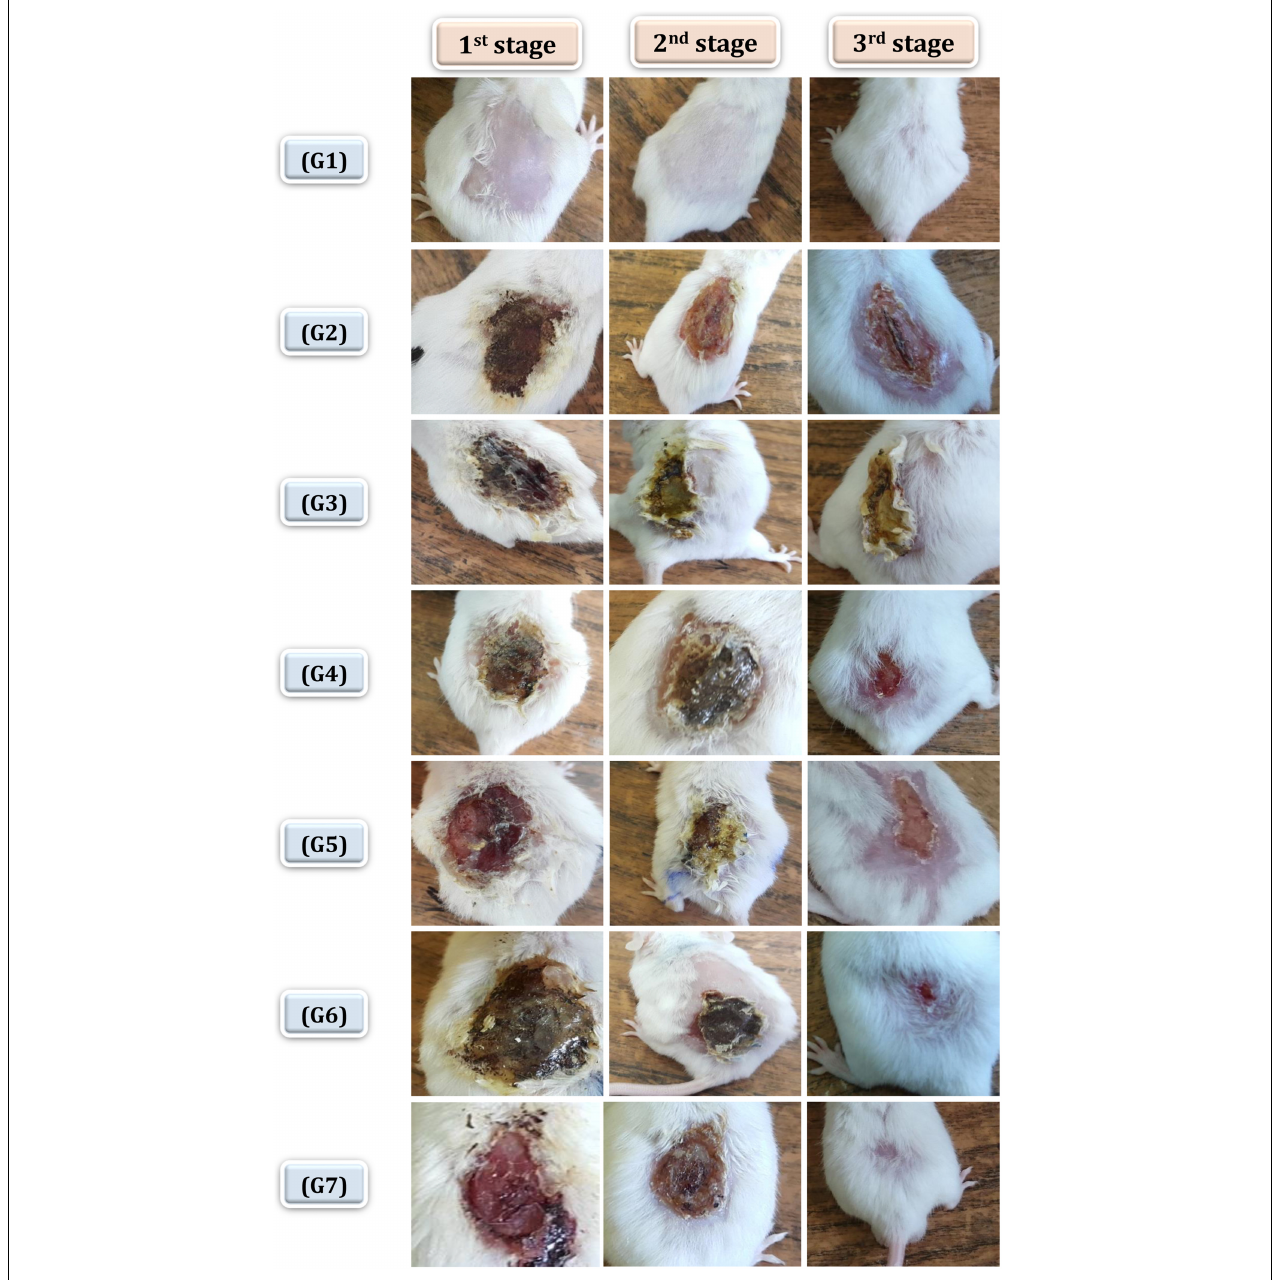
FIGURE 7 | Healing progress in mice groups after different days of treatment. G1 normal group (negative control), G2 infected and untreated (positive control), G3 infected, and treated with placebo base gel (positive control), G4 infected, and treated with Ag-NPs gel, G5 infected, and treated with neomycin gel, G6 infected, and treated with neomycin-Ag-NPs gel, G7 infected, and treated with neomycin- Ag-NPs spray. 1st stage: after 3 days of initial treatment, 2nd stage, at the treatment end time, 3rd stage: at the end of